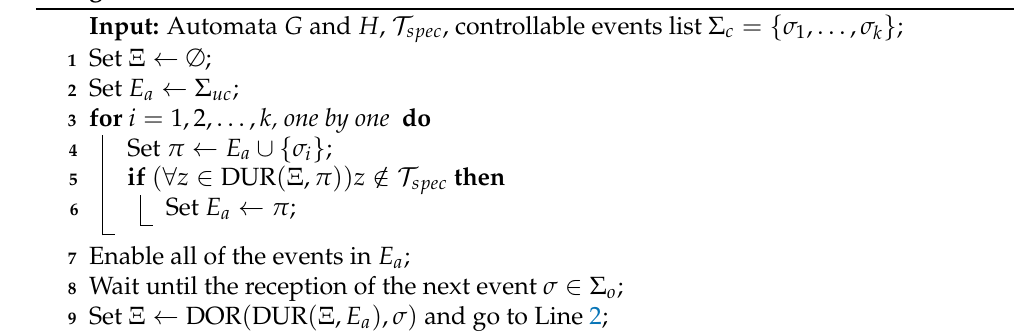
Algorithm 1: O NLINE MAXIMAL NETWORKED